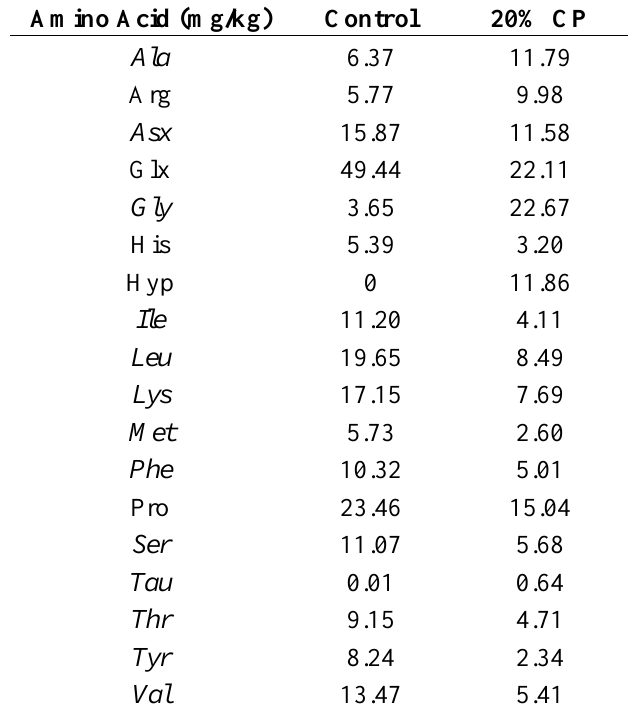
Table 1. Amino acid composition of the control diet and the 20% CP